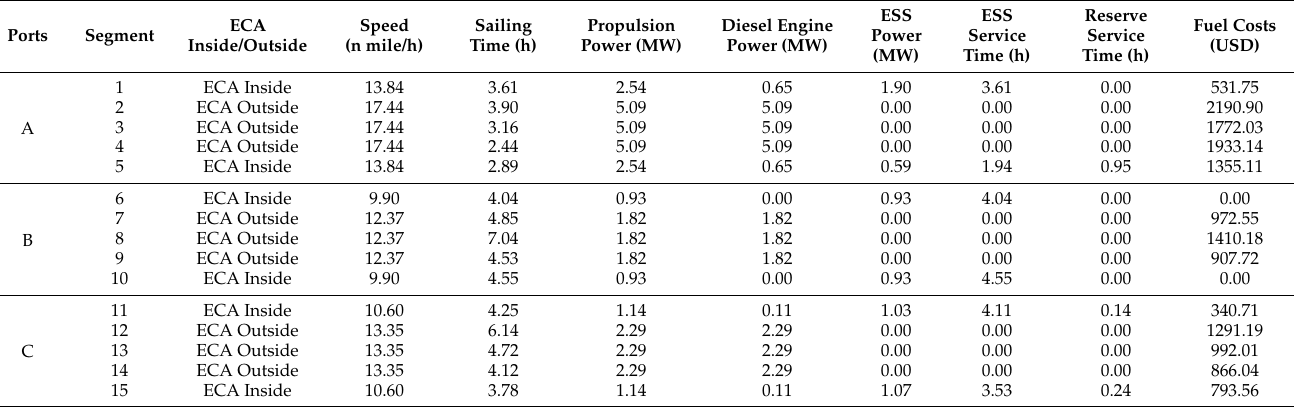
Table 7. The second stage energy management results without considering the maritime